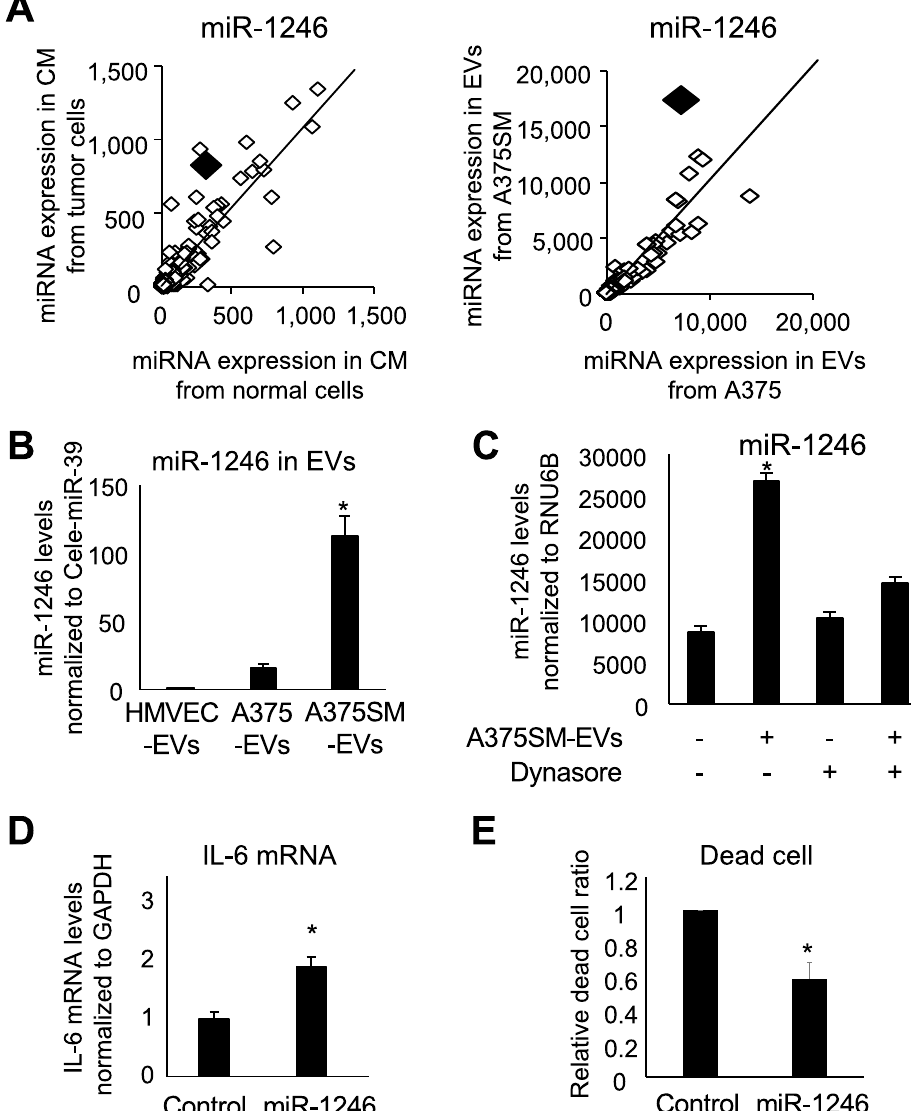
Figure 3. miR-1246 in A375SM EVs enhances IL6 mRNA expression in HMVECs. ( A ) miRNA array analysis in conditioned medium (CM) from tumor and normal cells (left) and in extracellular vesicles (EVs) from A375SM and A375 (right). Each miRNA was plotted. The black rhombus shows miR-1246. miR-1246 was high in both CM from tumor cells and EVs from A375SM. ( B ) miR-1246 expression in each EV was evaluated through real-time PCR (* P < 0.01 vs. HMVEC-EVs and A375-EVs, one-way ANOVA; data are presented as mean ± SD, n = 4 real-time RT-PCR runs). ( C ) miR-1246 expression in HMVECs was evaluated through real- time PCR with or without A375SM-EVs and dynasore (* P < 0.05, one-way ANOVA followed by post hoc Tukey’s test; data are presented as mean ± SD, n = 3 real-time RT-PCR runs). ( D ) IL-6 expression was evaluated through real-time PCR after transfection of miR-1246 in HMVECs. Control miRNA-transfected HMVECs was shown as control (* P < 0.01 vs. control, two-sided Student’s t -test; data are presented as mean ± SD, n = 3 real-time RT-PCR runs). ( E ) Dead cells were analyzed through flow cytometry using PI under 5-FU treatment condition for 72 h after transfection of miR-1246 in HMVECs. Control miRNA-transfected HMVECs was shown as Control. Data are presented as mean ± SD, n =